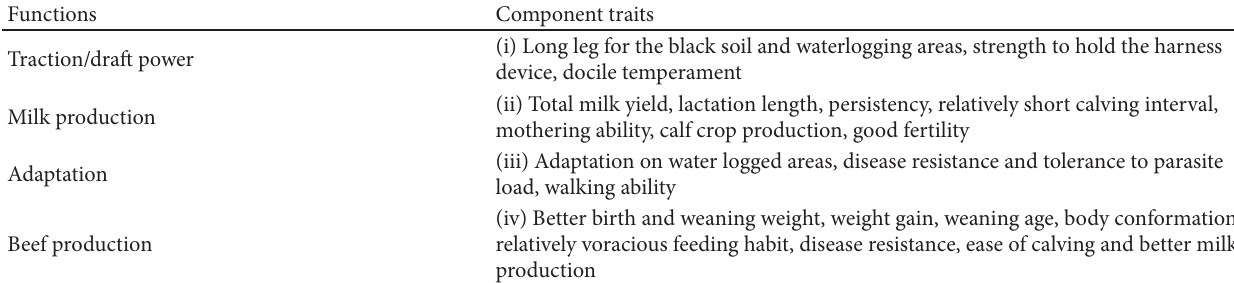
Table 4: Functional traits played by Fogera cattle for the community.